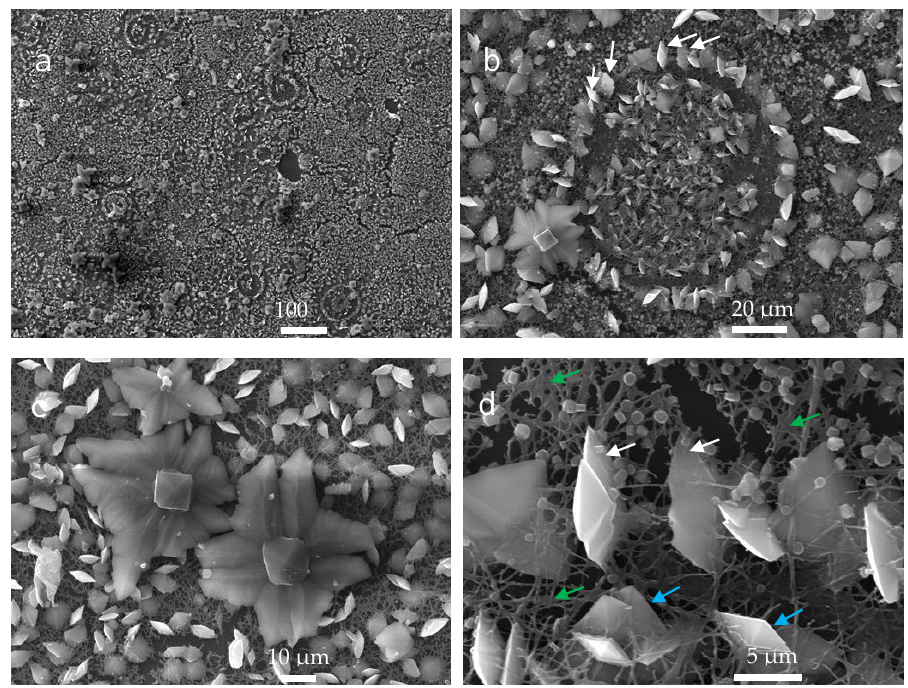
Figure 10. SEM images of CaOx crystals obtained via EC on ITO modified with R-chitosan fibers at different magnifications showing circumferential rearrangement with radial orientation ( a,b ) and flower-like crystals ( c ) and tetragonal COD ( d ) crystals. White, green, and light blue indicate radial orientation of crystals, fiber fusion, and the tetragonal COD phase, respectively.